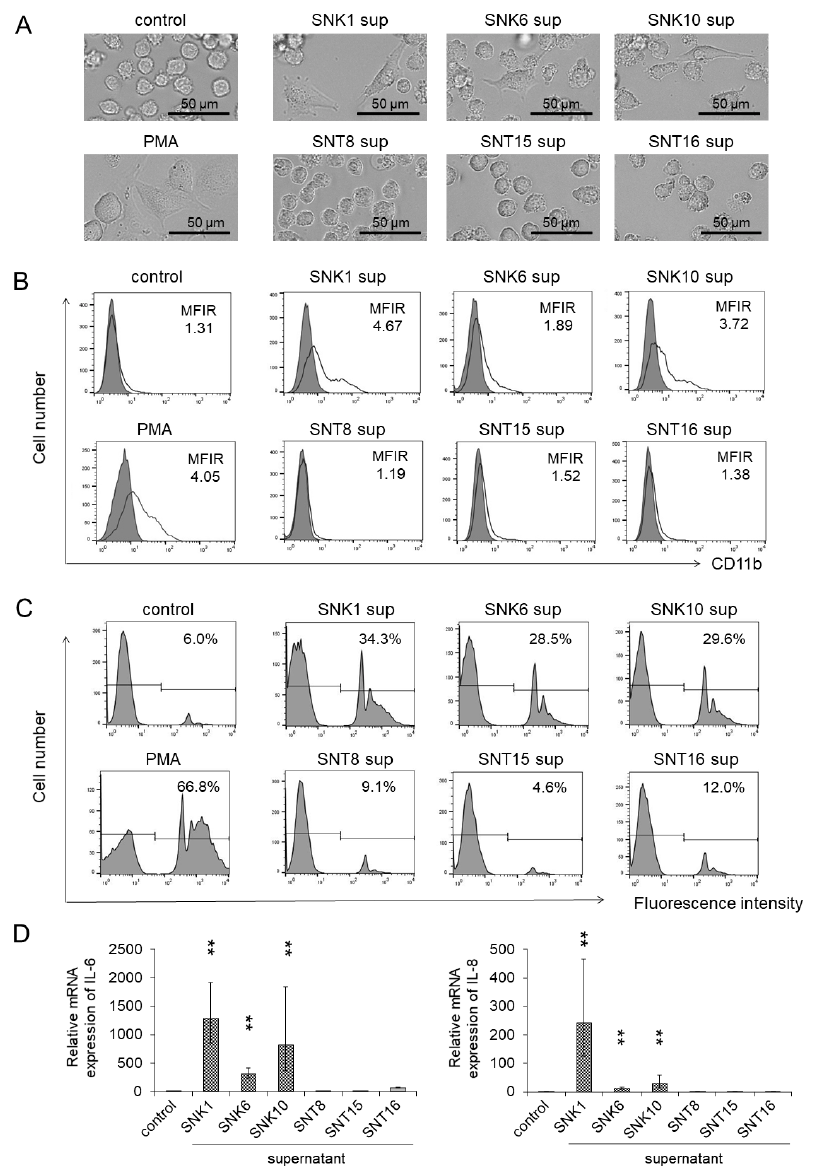
Figure 1. Macrophage-like differentiation and activation were promoted by the supernatants of EBV-positive NK-cell lines to THP-1 cells. THP-1 cells were co-cultured with each supernatant of EBV-positive T- or NK-cell lines for 72 h. After the co-culture, the target cells were subjected to each assay. The same amount of culture media of EBV-positive T- or NK-cell lines was added as an untreated control. PMA, a cell differentiation regulator, was used as a positive control. ( A ) The representative morphology of THP-1 cells was photographed by an optical microscope. ( B ) The CD11b expression on THP-1 cells was determined by flow cytometry using an antibody to CD11b (open histogram) or isotype-matched control (gray, shaded histogram). The mean fluorescent intensity of CD11b was normalized by the mean of isotype-matched control and is shown as the MFIR (mean fluorescence intensity rate). ( C ) The phagocytosis ability of THP-1 cells was examined by a fluorescent beads uptake assay. After co-culturing with each supernatant, THP-1 cells were incubated with the fluorescent beads for 4 h, and the uptake of these beads was detected by flow cytometry. The rate of fluorescence intensity positive was estimated as phagocytosis ability. ( D ) The mRNA expression of IL-6 and IL-8 in THP-1 cells was analyzed by qRT-PCR assay. The expression was normalized to GAPDH mRNA. The data are shown as the mean ± SD ( n = 3). Statistical analyses were assessed and indicated as ** p < 0.01 compared to the